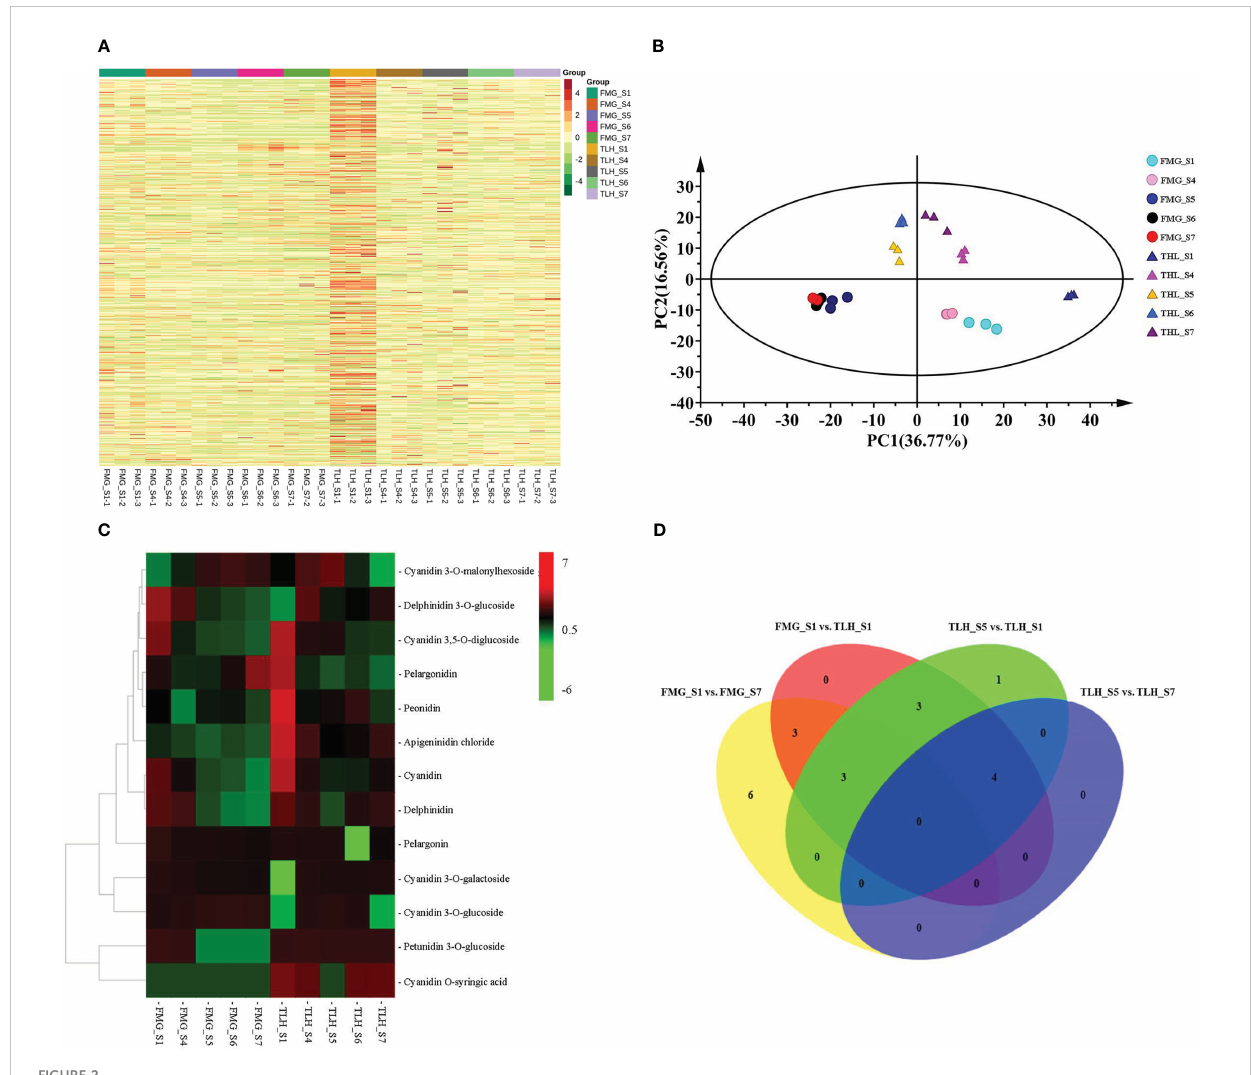
FIGURE 2 Qualitative and quantitative analysis of the metabolomics data of the peels of FMG and TLH. (A) Heatmap of the quanti fi ed identi fi ed metabolites. (B) PCA score plot of the metabolites in the FMG and TLH. (C) Heatmap of the quanti fi cation of the identi fi ed anthocyanins. (D) Venn diagram showing the number of metabolites in FMG_S1, FMG_S7, TLH_S1, TLH_S5, and